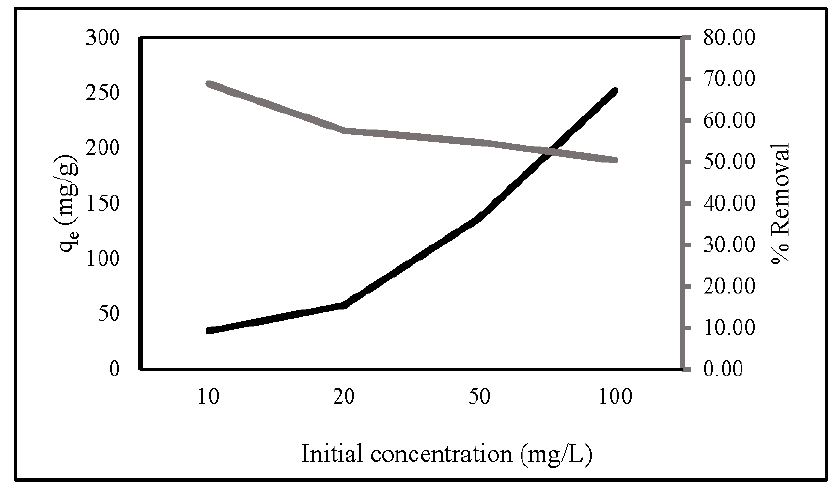
Figure 5. Effect of initial nitrate concentration on nitrate adsorption. (10 mg of ZLCH-Fe; contact time: 30 min; pH: 7).